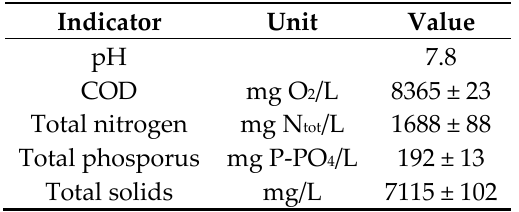
Table 1. Characteristic of anaerobically digested distillery stillage.